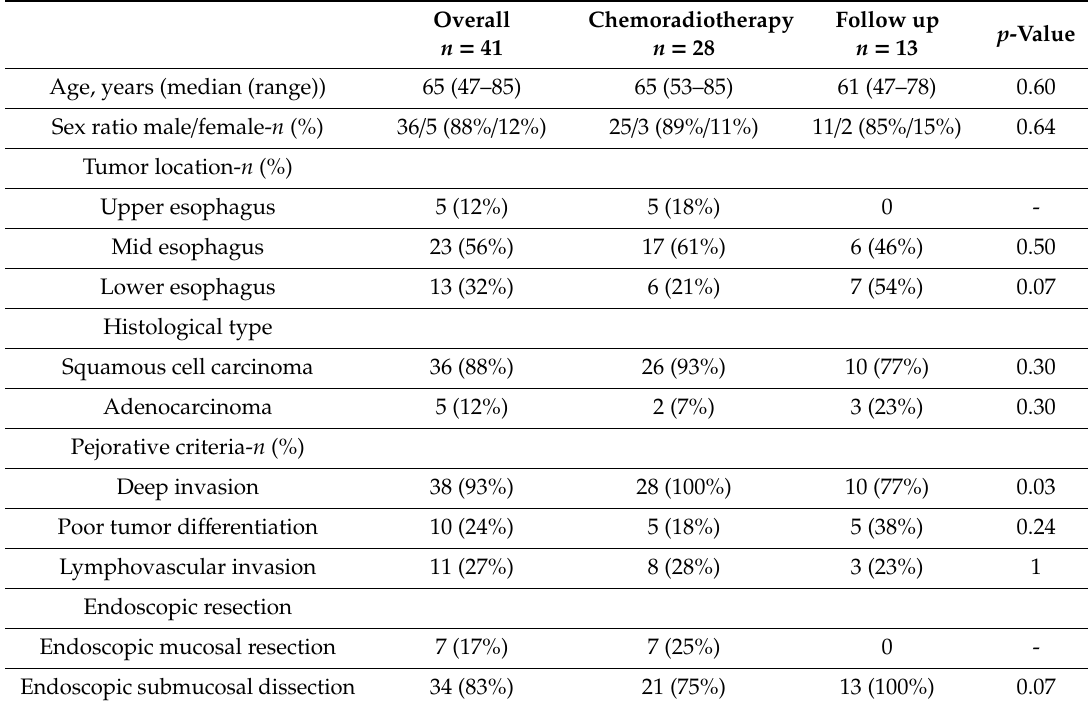
Table 1. Patients